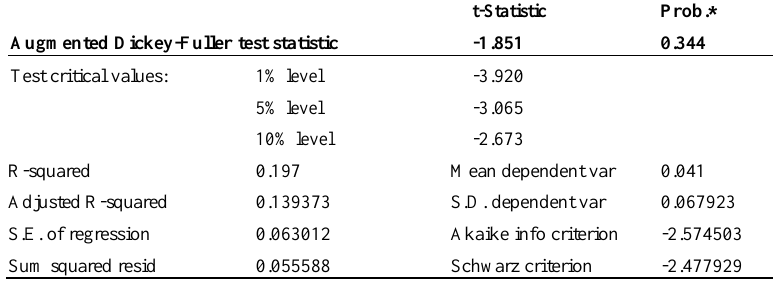
Table 5. Stationarity estimation of the ln (P) series by the DF test